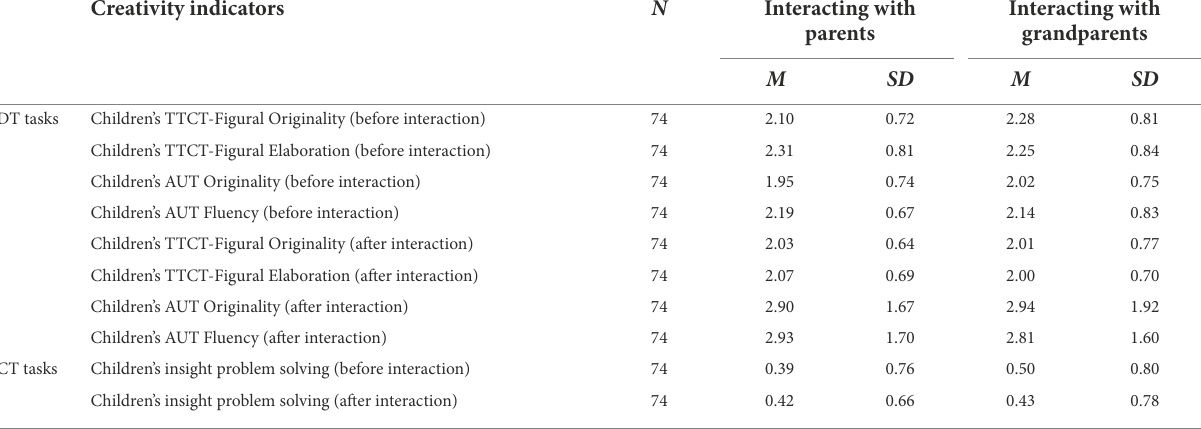
TABLE 5 Descriptive analysis of children’s creativity performance before and after interaction with adults. Creativity